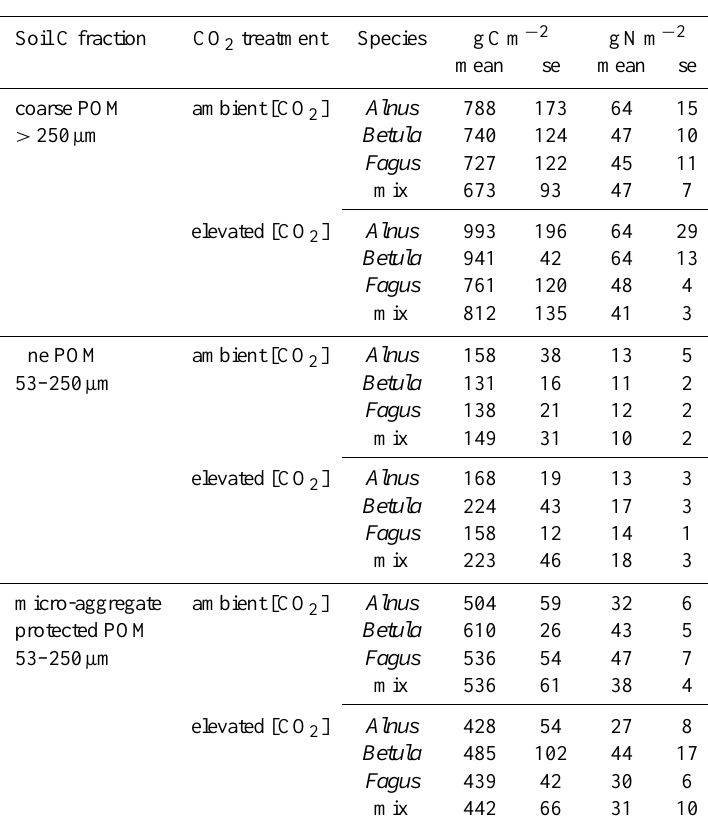
Table 4. C and N contents of isolated soil